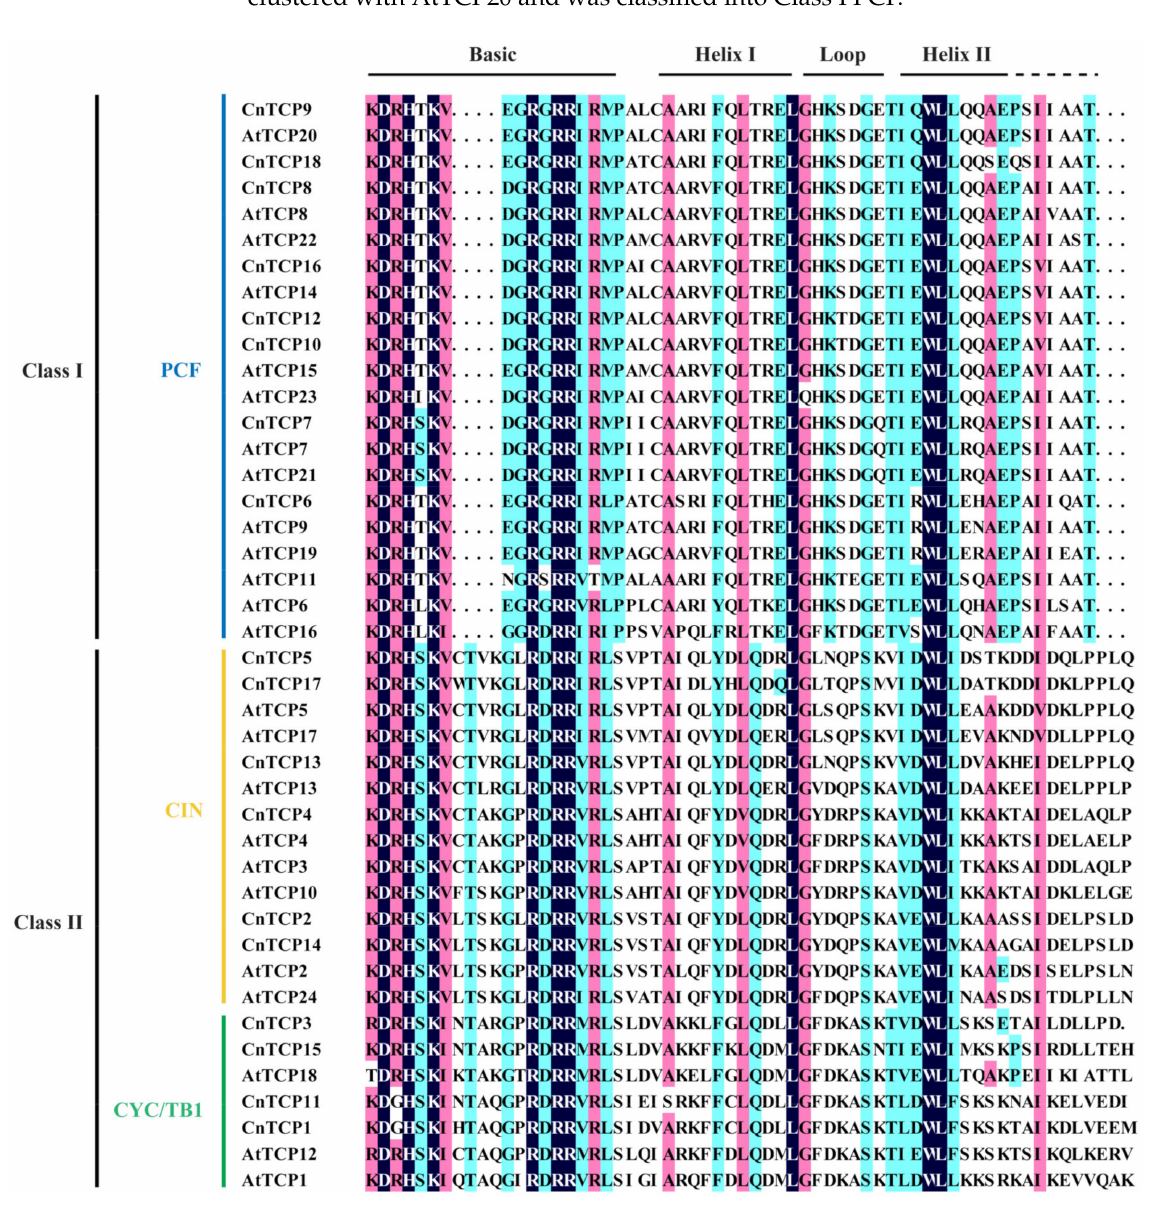
Figure 2. Amino acid alignment among TCP proteins. Amino acids alignment using the bHLH domain amino acid sequences of TCP proteins from Chrysanthemum nankingense and Arabidopsis thaliana . The blue line shows PCF subfamily in class I; the yellow line shows CIN subfamily in class II; the green line shows CYC/TB1 subfamily in class